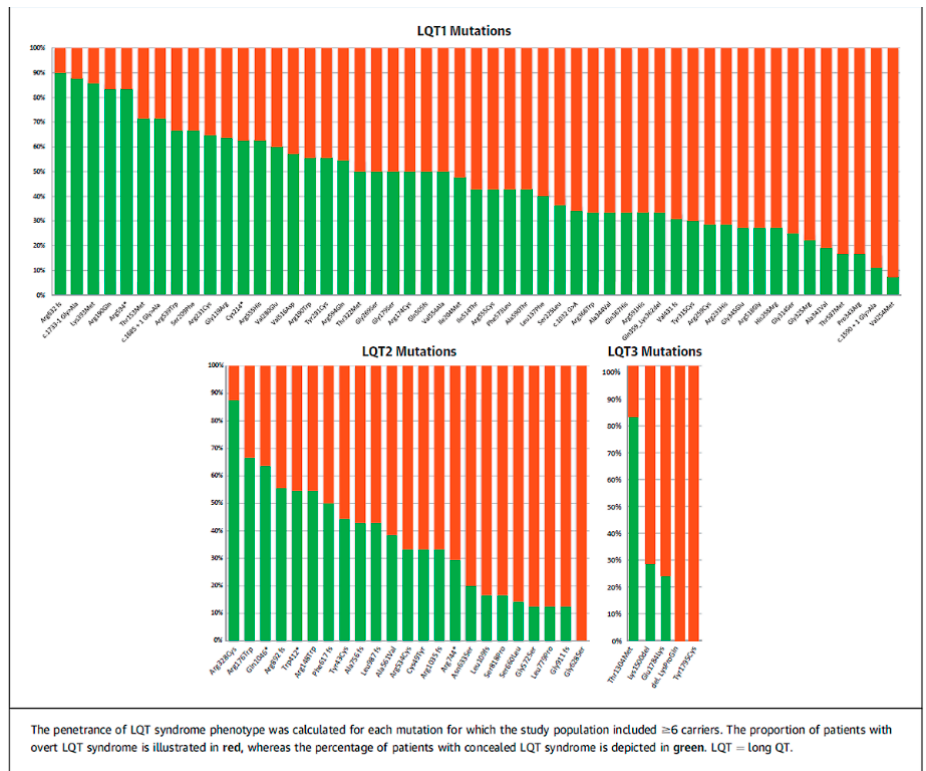
Figure 3. From reference [15] illustrates the distribution between concealed (green fraction) and overt (red fraction) in 53 mutations with LQT1, 23 mutations with LQT2 and 5 mutations in LQT3. Reproduced with permission from Elsevier Publisher.